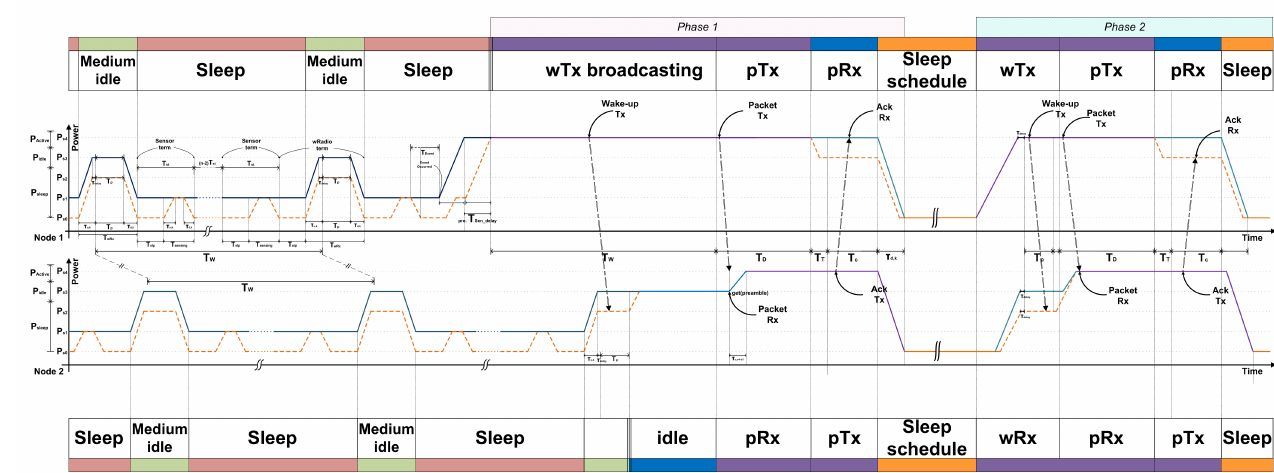
Figure 12. Energy state transition in WiseMAC protocol-based node